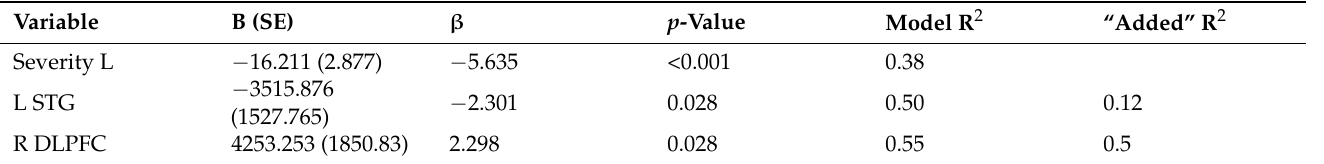
Table 3. Significant predictors of letter fluency: stepwise regression with demographic, clinical and ROIs as predictors. Severity L = language severity score at the fronto-temporal dementia scale; R DLPFC = right dorsolateral prefrontal cortex; L STG = left superior temporal gyrus. The added R-squared from the regression model refers to the additional variance explained by including the given